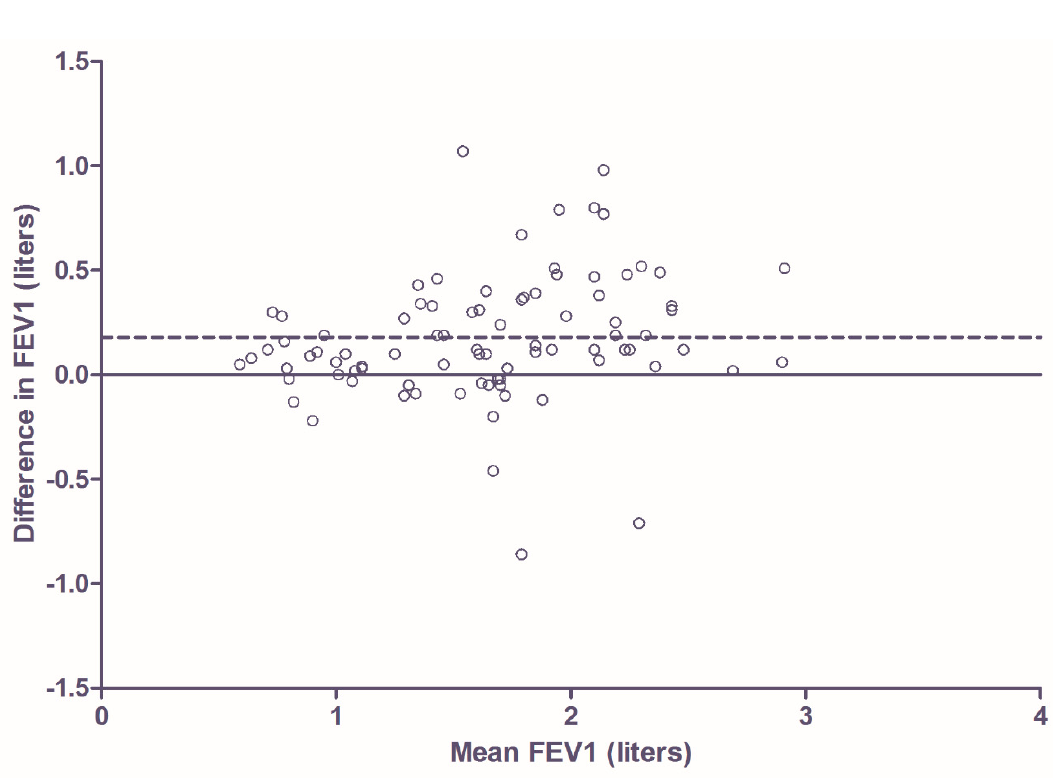
Figure 1. Bland-Altman plot showing degree of agreement between the two types of measurement in patients with CF. Difference in FEV1 is calculated by subtracting home FEV1 measurement from clinical FEV1 measurement. The dotted line shows the mean difference (0.18 L).